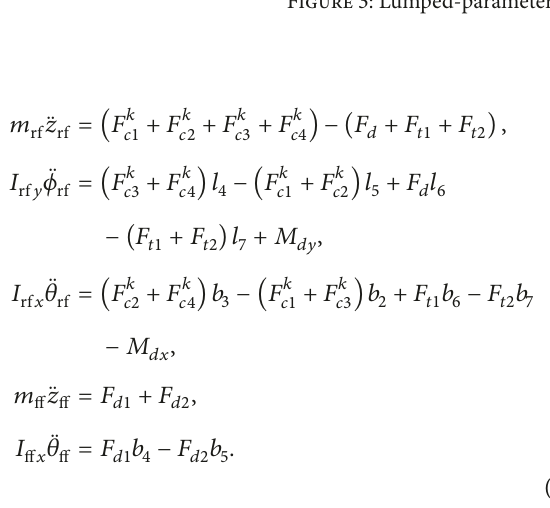
Figure 3: Lumped-parameter models of three cab’s isolation